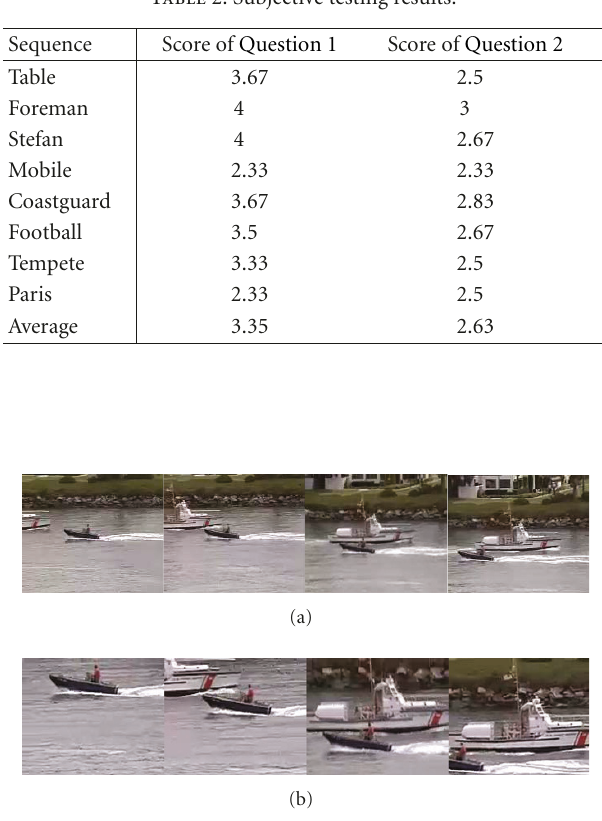
Table 2: Subjective testing results.